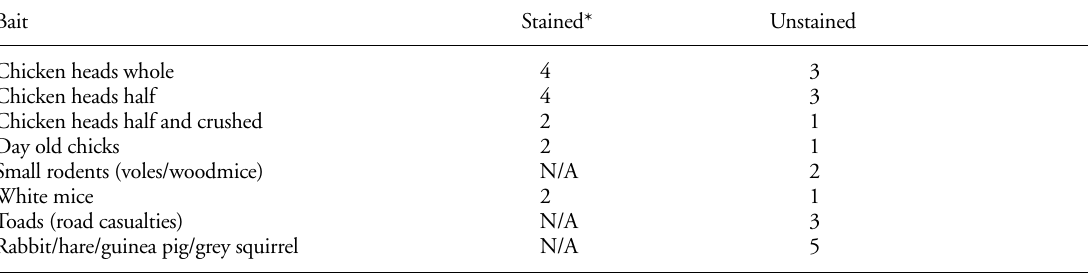
Table 6. Ranked removal rate for baits used (1 = most rapidly removed – all expts). Bait Stained* Unstained Chicken heads whole 4 3 Chicken heads half 4 3 Chicken heads half and crushed 2 1 Day old chicks 2 White mice